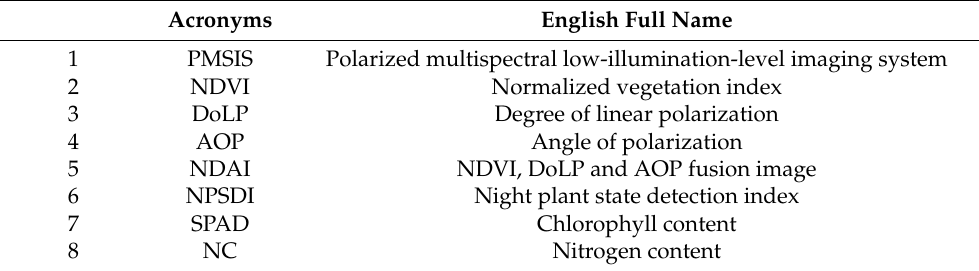
Table 2. List of acronyms with their